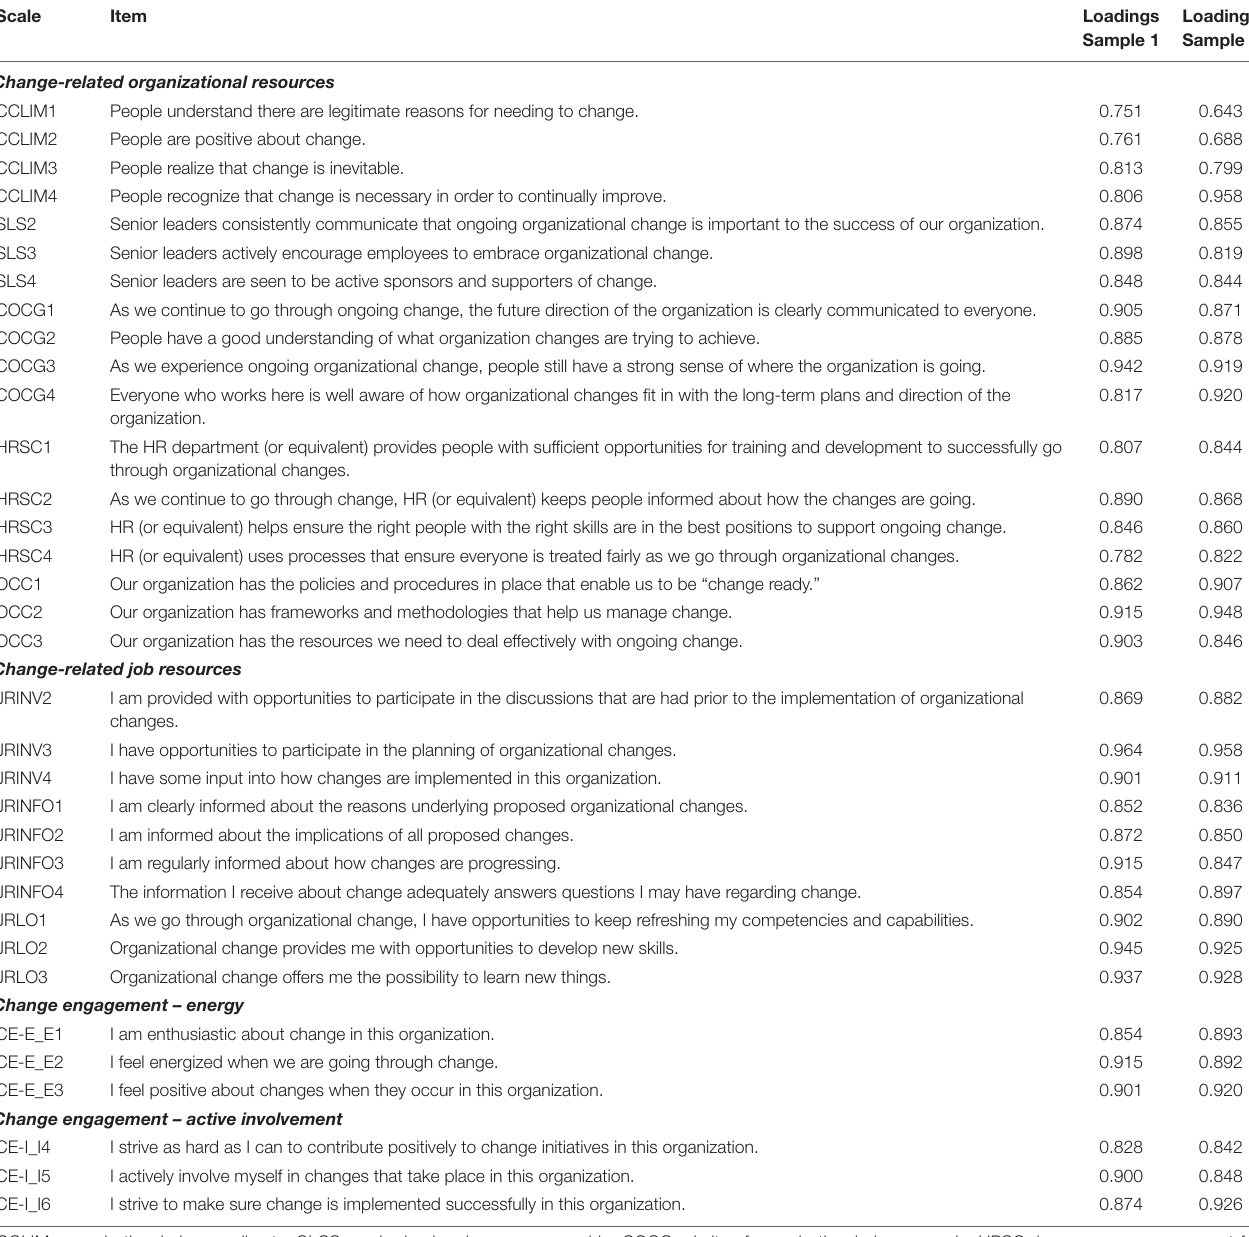
TABLE 1 | Respecified CFA items and their loadings Sample 1 and Sample 2. Scale